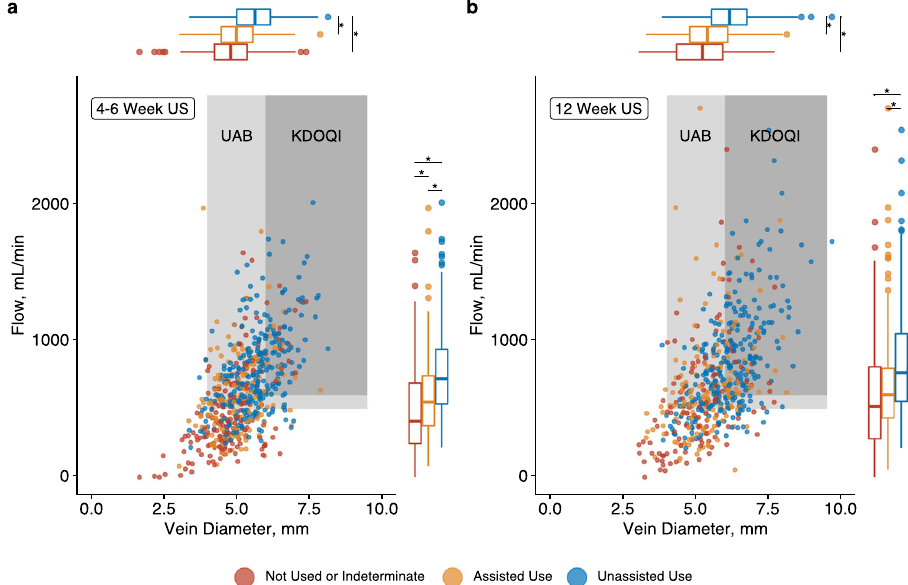
Fig. 2 Ultrasound parameters strati fi ed by arteriovenous fi stula (AVF) use at 1-year. Points represent individual patients ’ values. Data presented for 4 to 6 week a and 12 week b ultrasounds. Box plots depict median (center line), interquartile range (box bounds, 25 th and 75 th percentiles), largest value no further than 1.5 times the interquartile range (whiskers), and outlying values more than 1.5 times the interquartile range plotted individually. Colors represent AVF use category (red: not used or indeterminate, orange: assisted use, blue: unassisted use). Shaded areas correspond to fl ow and diameter thresholds for UAB ( ≥ 500 mL/min and ≥ 4 mm, light gray) and KDOQI ( ≥ 600 mL/min and ≥ 6 mm, dark gray) ultrasound criteria. Results of post hoc testing comparing fl ow and diameter between groups (Tukey ’ s test) are represented by asterisks (* p <